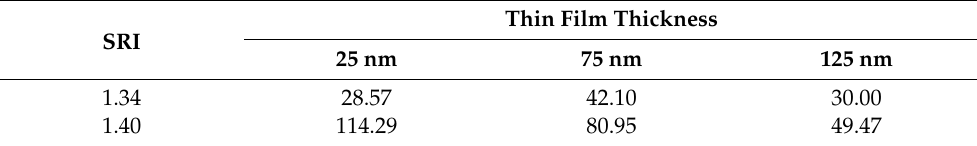
Table 3. FOM (RIU − 1 ) for a neck of − 2 µ